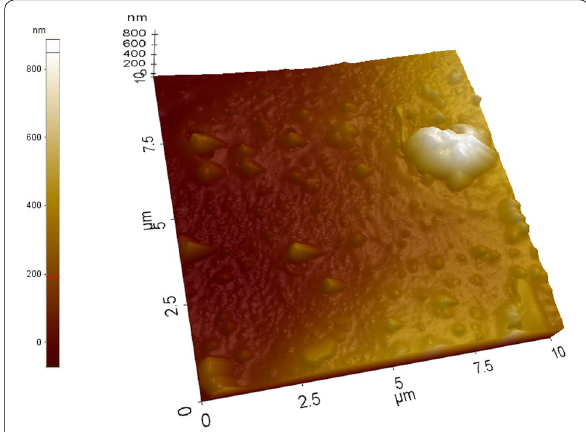
Fig. 10 AFM image of Pd nanoparticles incorporated PAni